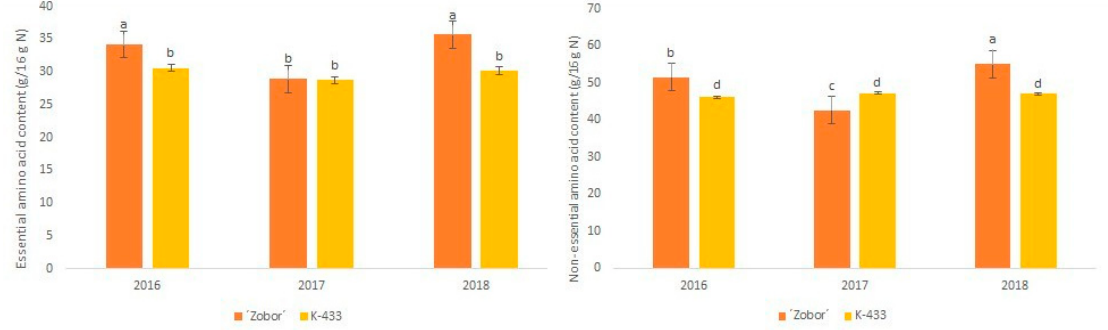
Figure 3. Effect of the growing season on contents of the total essential and nonessential amino acids in mutant variety “Zobor” and control K-433. Different letters on bars indicate significant differences by the Tukey test ( p ≤ 0.05).